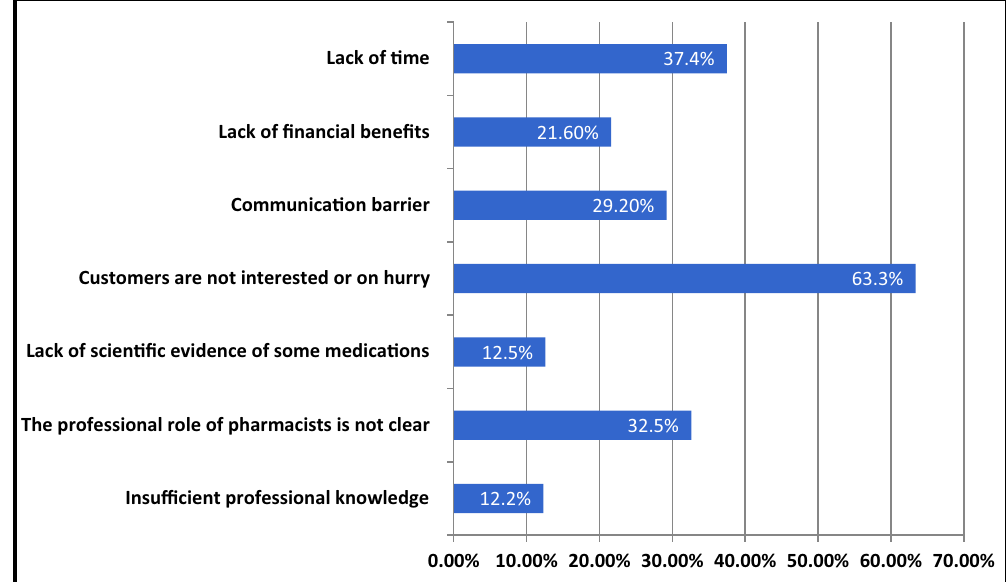
Figure 1. Barriers that prevents pharmaceutical care